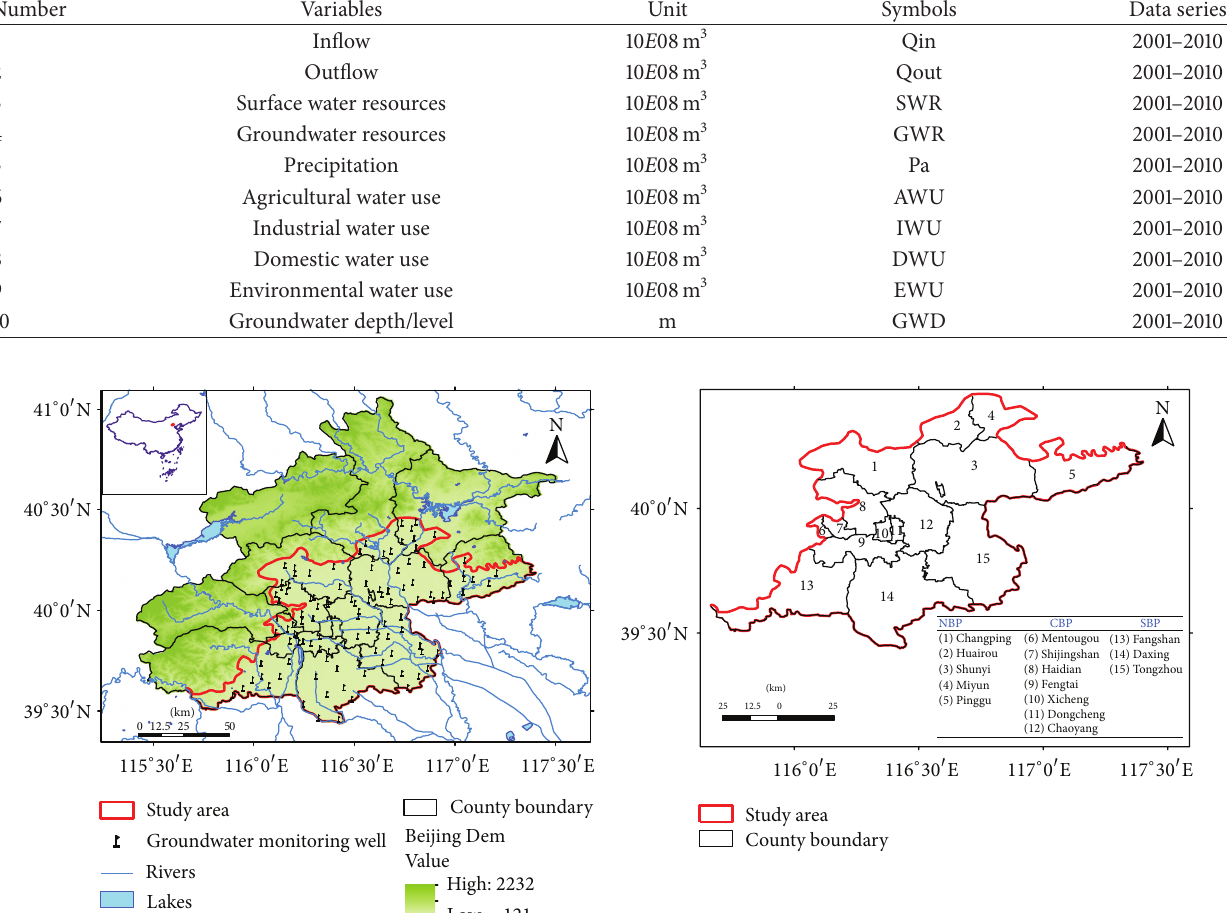
Table 1: Variables selected from the Beijing Water System.